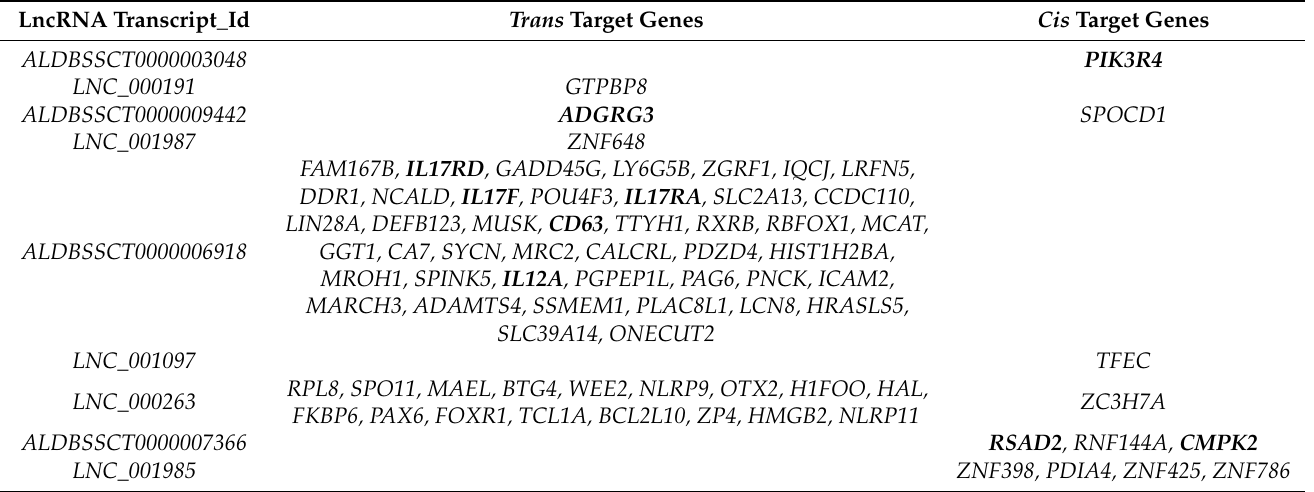
Figure 5. The secondary structures of 10 lncRNAs. ( A ) LNC_001595; ( B ) ALDBSSCT0000003048; ( C ) LNC_000191; ( D ) ALDBSSCT0000009442; ( E ) LNC_001065; ( F ) ALDBSSCT0000006918; ( G ) LNC_000263; ( H ) LNC_002009; ( I ) ALDBSSCT0000007366; ( J ) LNC_000042. Table 2. Target gene prediction of potential diarrheic resistance